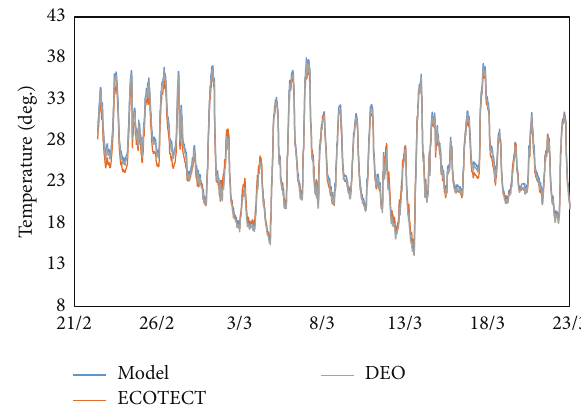
Figure 13: Comparison of simulation results of ECOTECT, DOE, and the